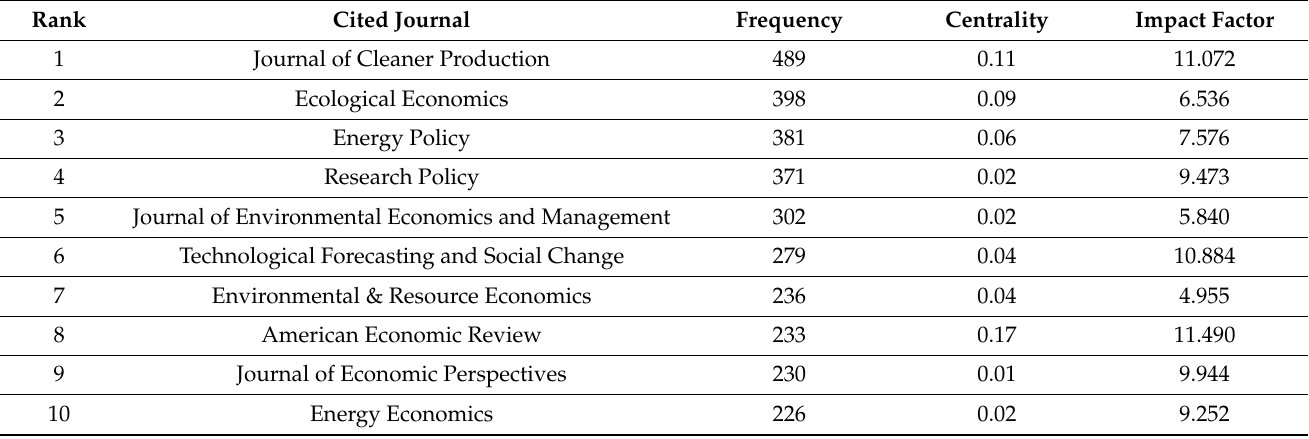
Table 6. Top 10 co-cited